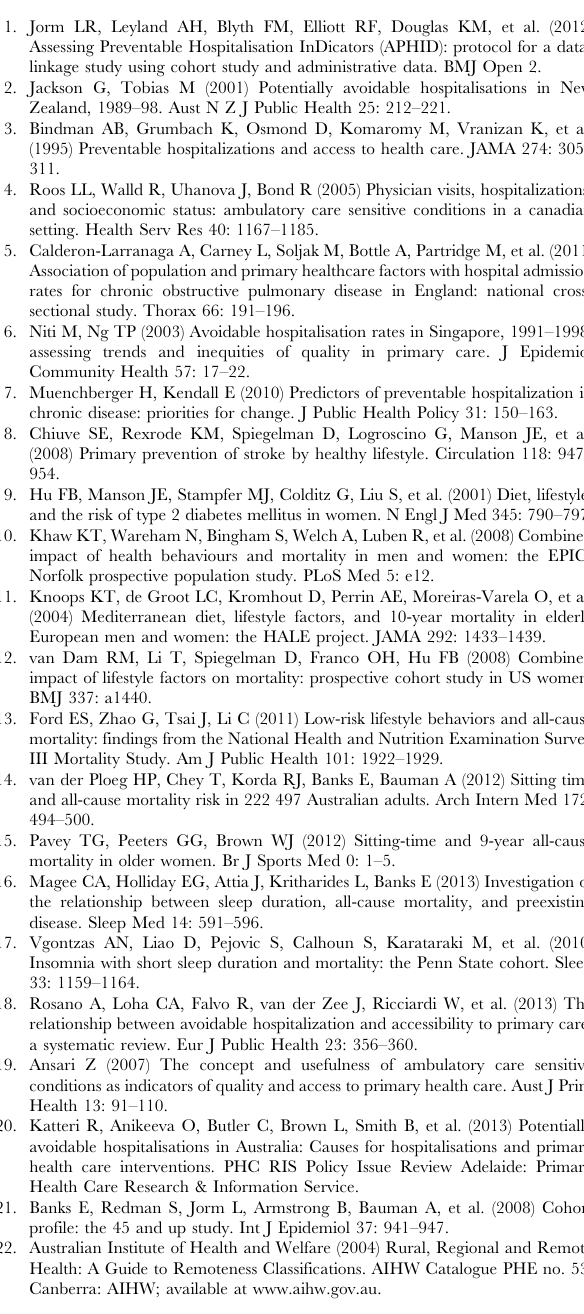
Table S3 Risk of mortality by number of positive health